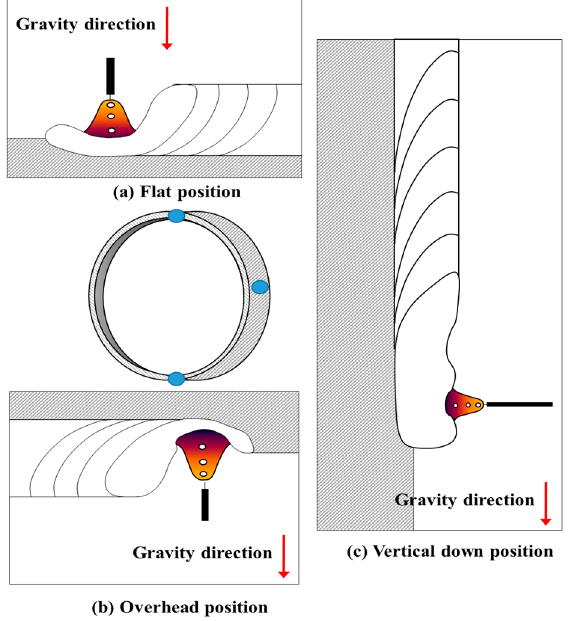
Table 1. Experiment conditions. Parameter